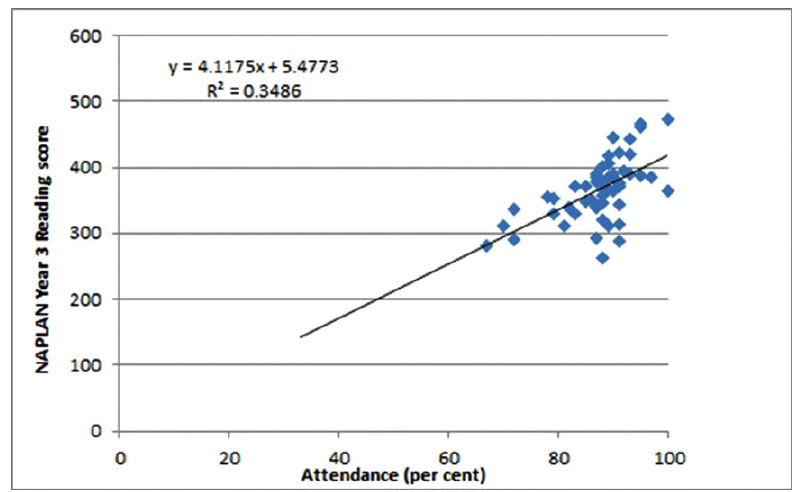
(Colour online) NAPLAN Year 3 Reading scores for very remote schools with less than or equal to 80% Aboriginal and Torres Strait Islander students, by per cent school attendance, 2012 (n =